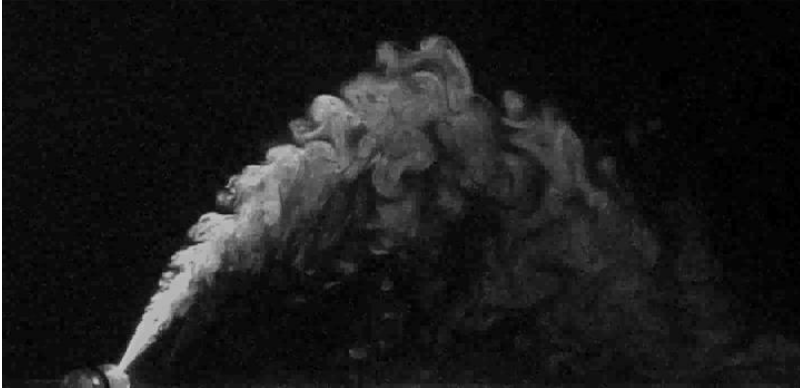
Figure 2. An instantaneous visualization of the concentration field for an inclined negatively buoyant jet with Fr = 28.0 and θ = 67° released into a stagnant receiving body.